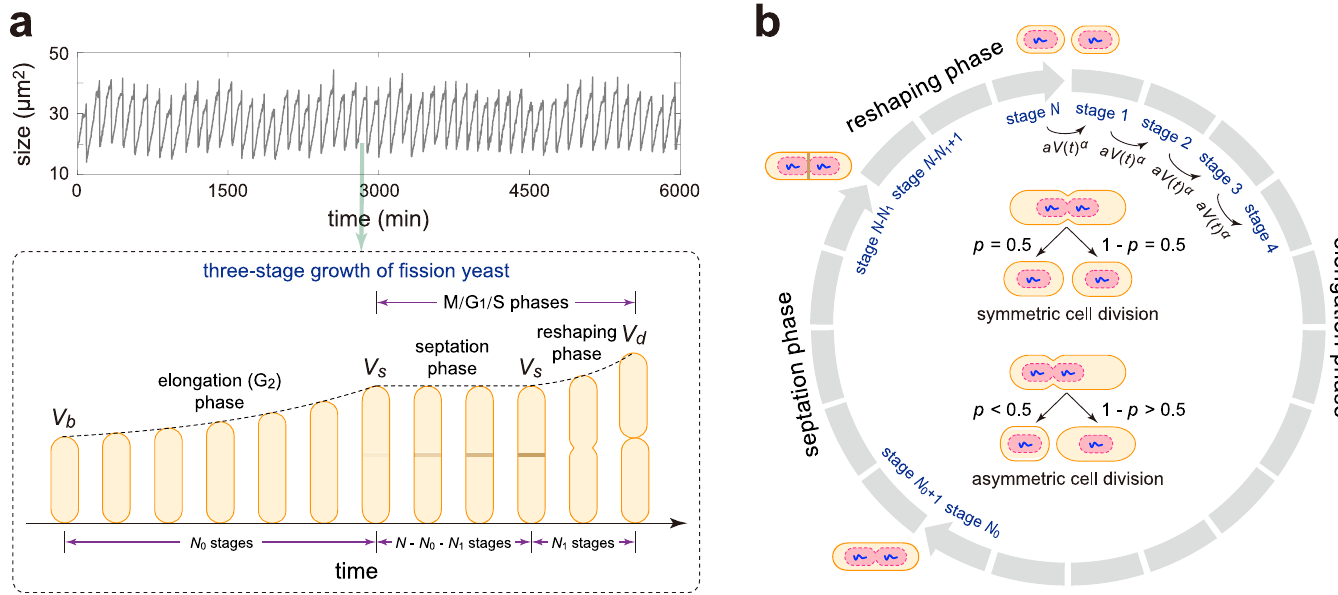
Fig 2. A detailed model of cell size dynamics in fission yeast. A : Three-stage growth pattern of fission yeast: an elongation (G 2 ) phase where cell size grows exponentially with rate g 0 , followed by a septation phase during which the septum is formed and cell size remains constant, and then followed by a reshaping phase where cell length increases abruptly with a higher exponential growth rate g 1 > g 0 . Here V b is the size at birth, V s is the size at septation, and V d is the size at division. B : Schematic illustrating a detailed model of cell size dynamics describing three cell growth phases, size homeostasis, and symmetric or asymmetric partitioning at cell division (see inset graph). Each cell can exist in N effective cell cycle stages. Cell elongation occurs during the first N 0 stages, septation occurs during the intermediate N − N 0 − N 1 stages, and reshaping of the new cell end occurs during the last N 1 stages. The transition rate from one stage to the next at time t is proportional to the α th power of the cell size V ( t ) with α > 0 being the strength of size control and a > 0 being the proportionality constant. This guarantees that larger cells at birth divide faster than smaller ones to achieve size homeostasis. At stage N , a mother cell divides into two daughters that are typically different in size via asymmetric cell division. Symmetric division is the special case where daughters are